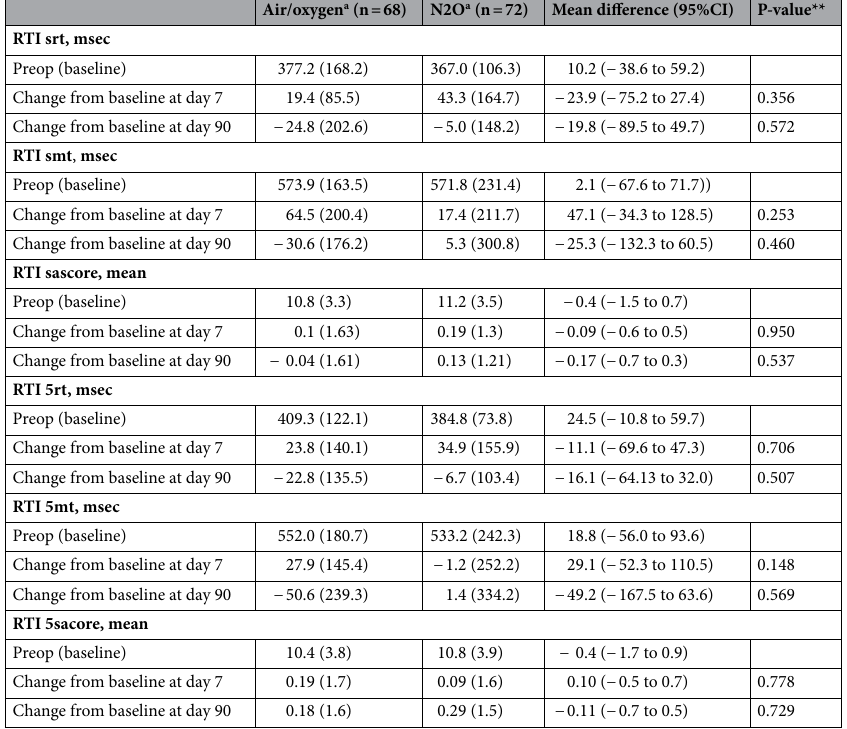
Table 4. Group differences for outcome measures of the reaction time test (RTI). RTIsrt, simple reaction time (msec) or speed of press pad release following single stimulus; RTIsmt, simple movement time (msec) or time to press a single stimulus after press pad release, RTI sascore, simple accuracy score or total number of correct trials out of 15 for a single stimulus; RTI 5rt, five choice reaction time (msec) or speed of press pad release following five different stimulus; RTI 5mt, five choice movement time (msec) or time to press one out of five stimulus after press pad release, RTI 5sacore, five choice accuracy score or total number of correct trials out of 15 for a five choice stimulus. **Change from baseline was compared between trial groups with t tests. In addition, a modification of the effect from day 7 to day 90 was tested with an interaction term in a linear regression model with mixed effects and was not found statistically significant (p-values from 0.16 to 0.95). a All data are presented as mean (± SD).